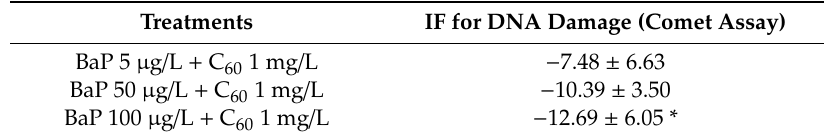
Figure 4. 8-oxodGuo levels in the digestive gland of mussels. Asterisks indicate the statistical differences observed between control and exposed groups. (**) p < 0.01.